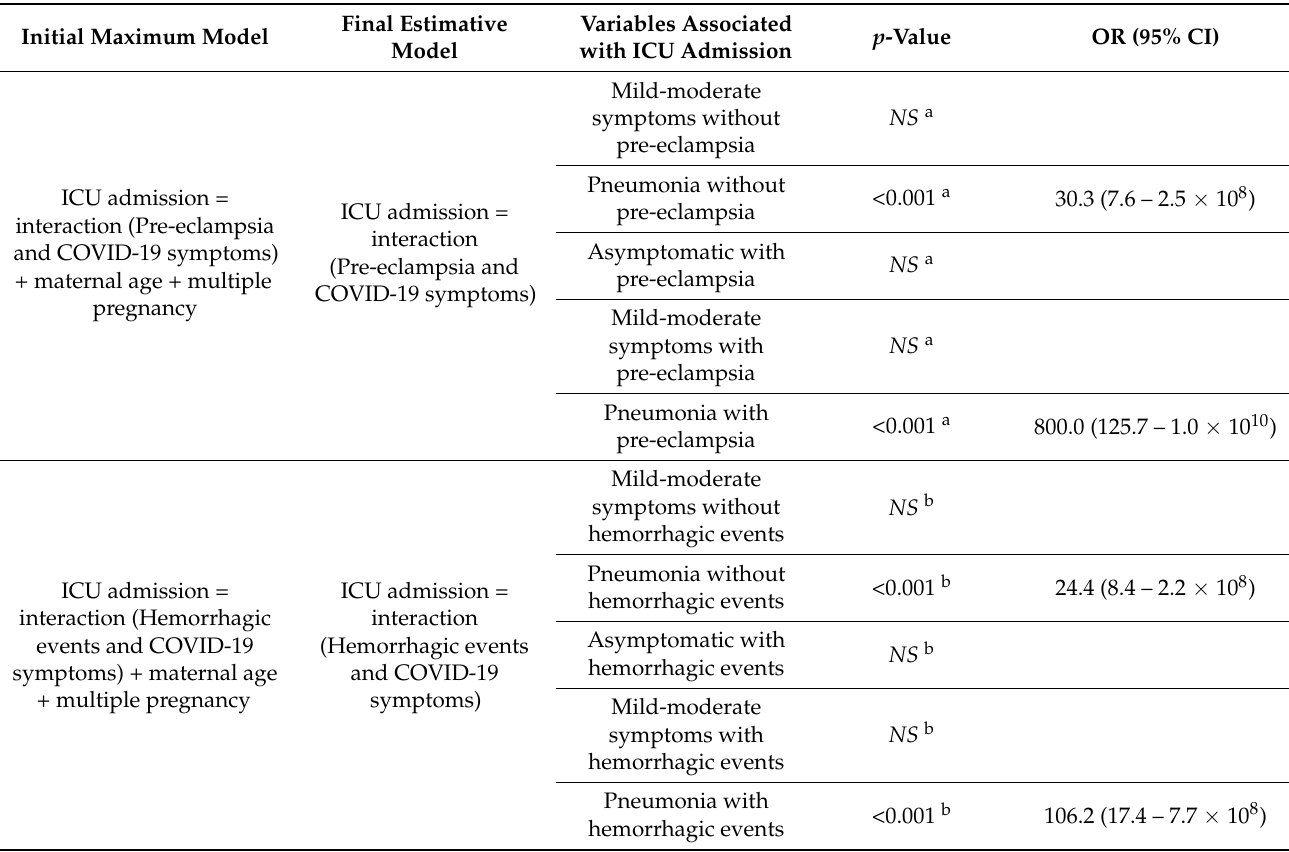
Table 4. Multivariable analysis of ICU admission